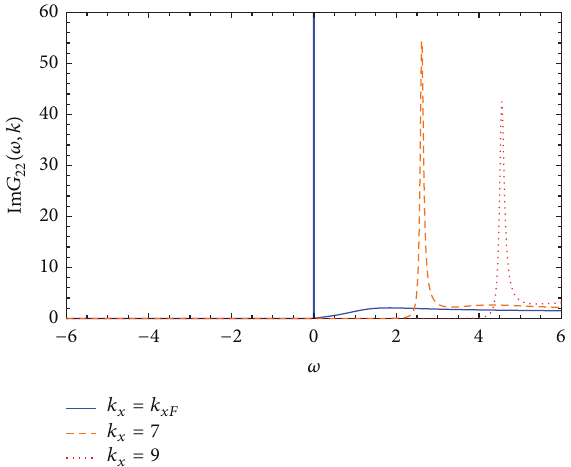
Figure 1: Spectral function Im 𝐺 22 (𝜔,𝑘) at 𝑘 𝑥 = 𝑘 𝑥𝐹 (blue solid), = 7 (orange dashed), and 𝑘 𝑘 𝑥